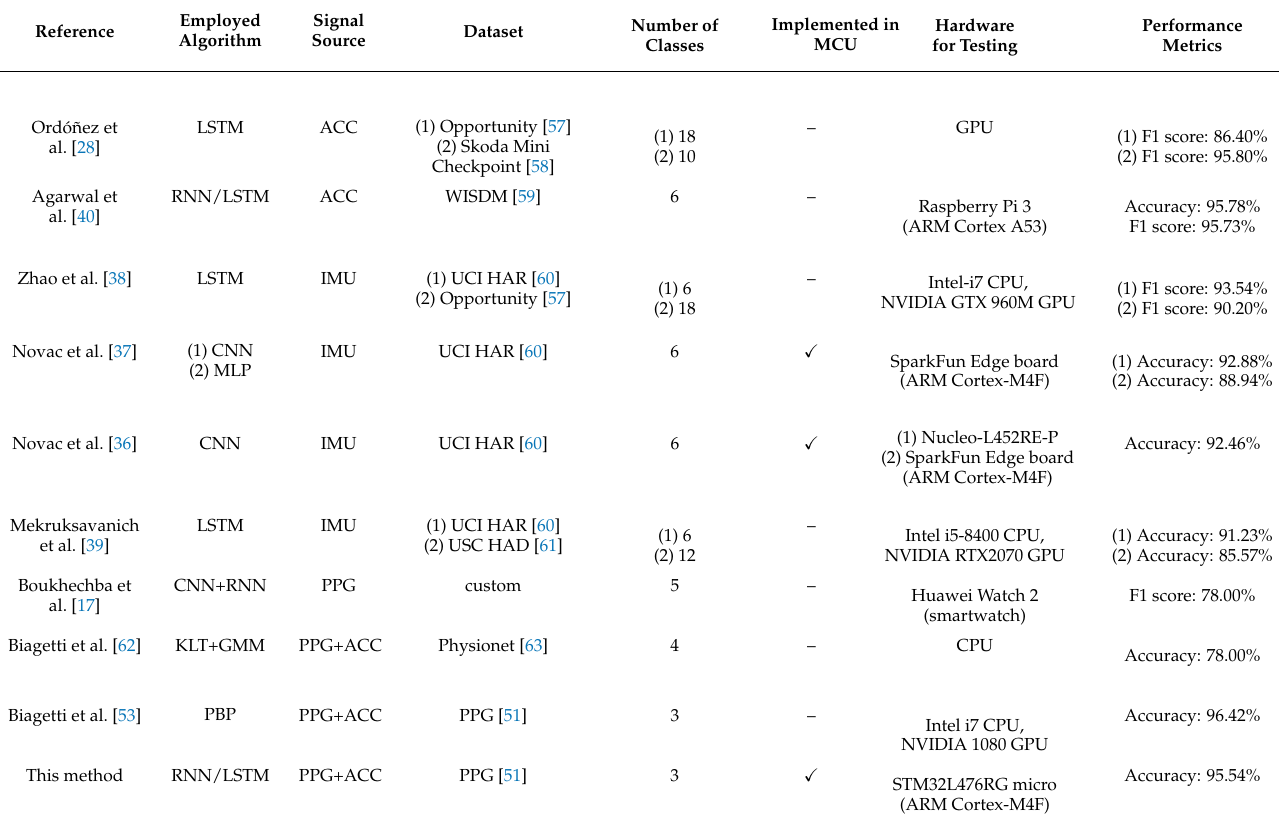
Table 8. Performance of the state-of-the-art HAR